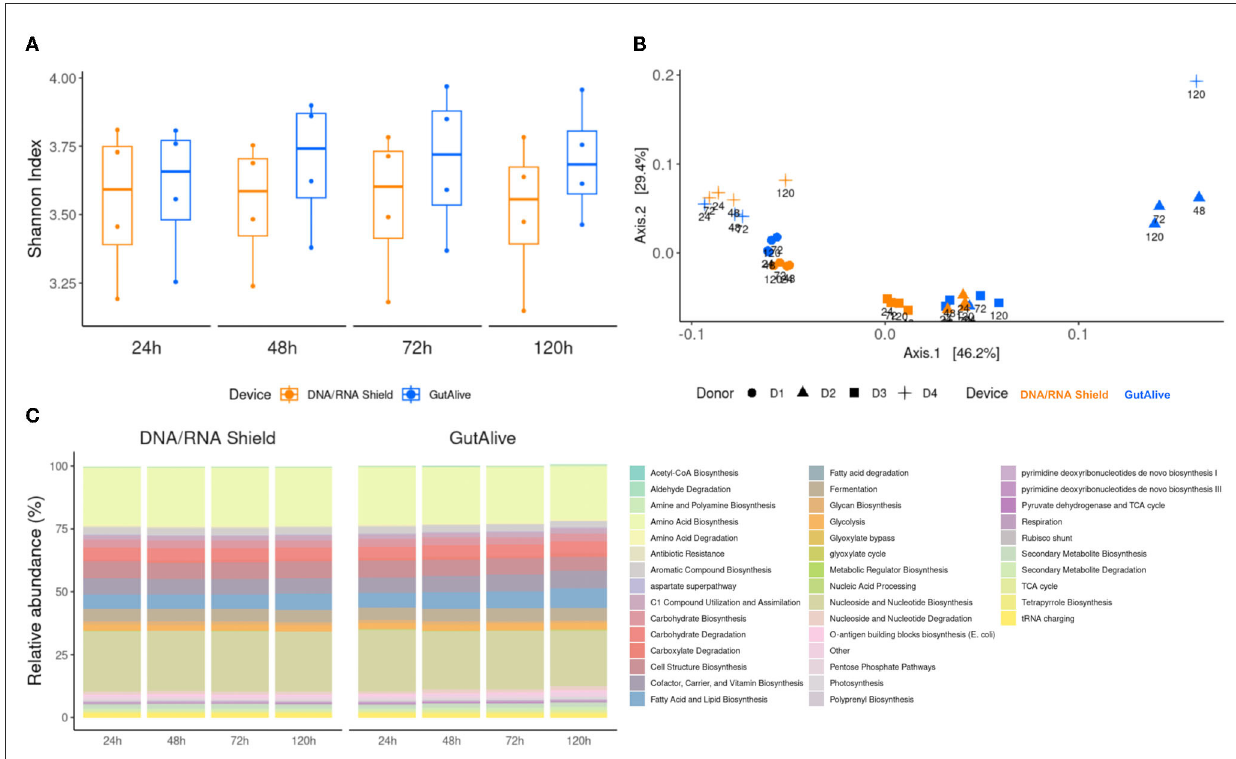
FIGURE4 Functional profiling and alpha and beta divergences. (A) Shannon index. (B) PCoA of Bray–Curtis distance. (C) Functional categories of cross-sectional study functionalities of the identified metabolic pathways and relative abundance.